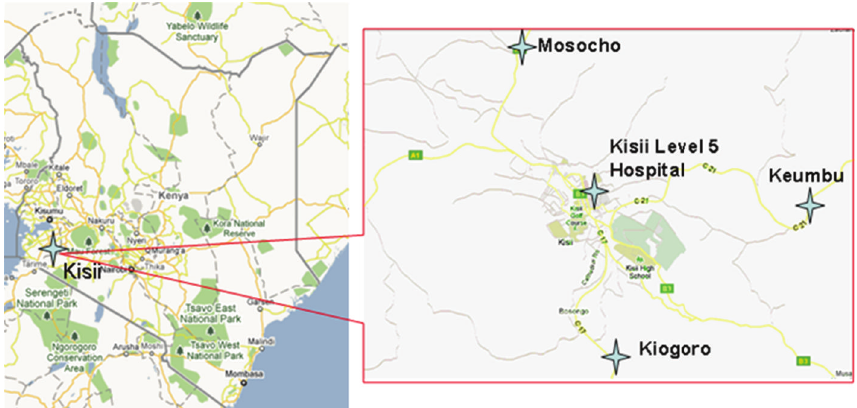
Figure 1: Map of Kenya showing Kisii, Nyanza Province, and inset showing the location of the three campaign sites and Kisii Level 5 Hospital (Kisii